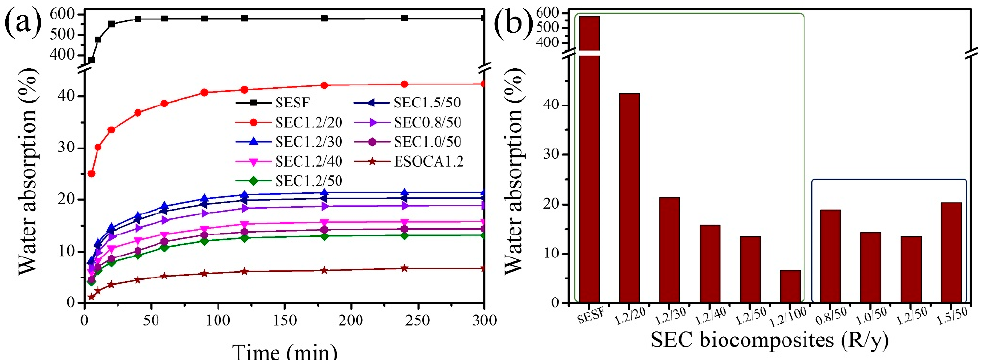
Figure 8. Water absorption of SEC biocomposites with different R values and ESOCA resin content, ( a ) water absorption depending on time, ( b ) maximum water absorption.